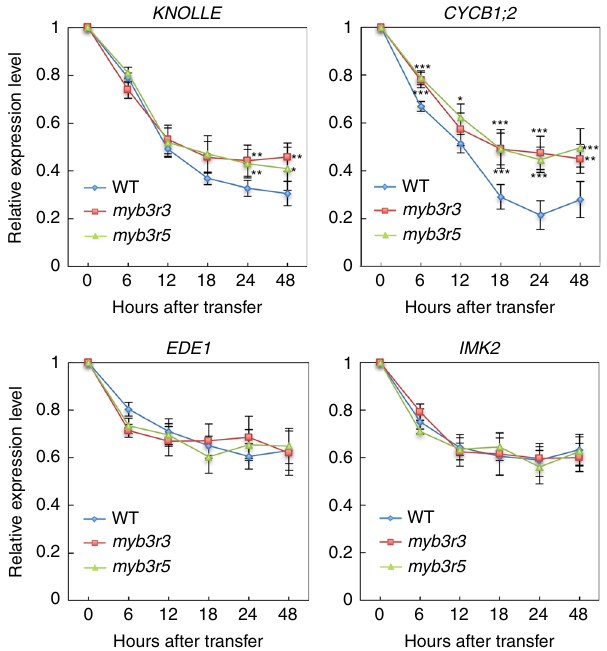
Fig. 9 Quantitative RT-PCR analysis of G2/M-speci fi c genes. Six-day-old seedlings were transferred to medium containing 2 µ M zeocin and grown for the indicated times. Total RNA was isolated from the region 1 cm from the root tip. The expression levels were normalized to that of ACTIN2 , and are indicated as relative values, with that for the time of transfer to zeocin- containing medium set to 1. Data are presented as mean ± SD of three biological replicates. Signi fi cant differences from WT were determined by